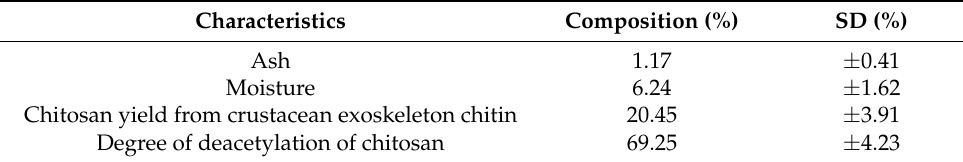
Table 2. Percentage yield from the chitosan extraction